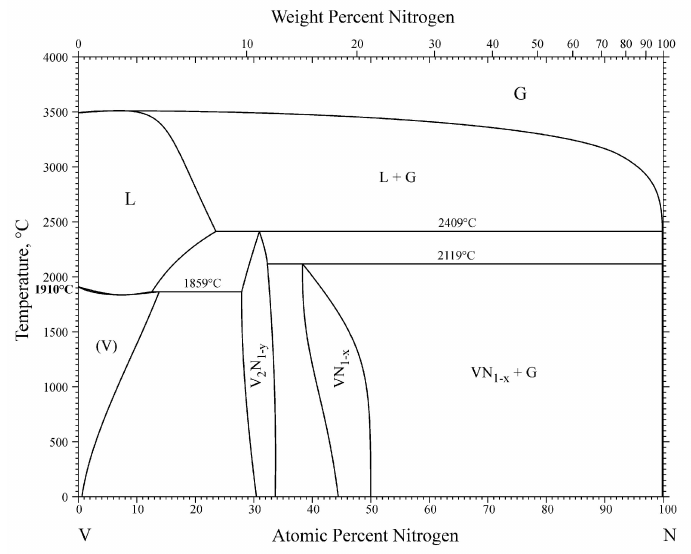
Figure 10. The phase diagram V-N at 1 atm [59,60].